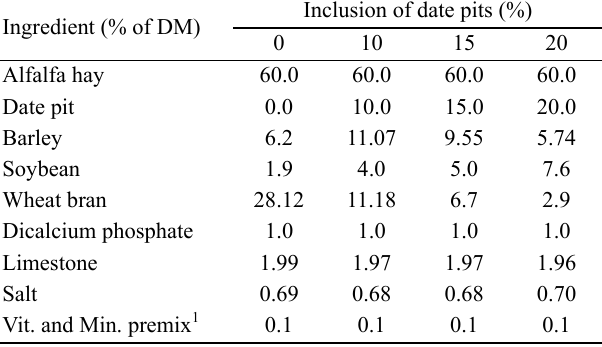
Table 1. Ingredients of the experimental diets